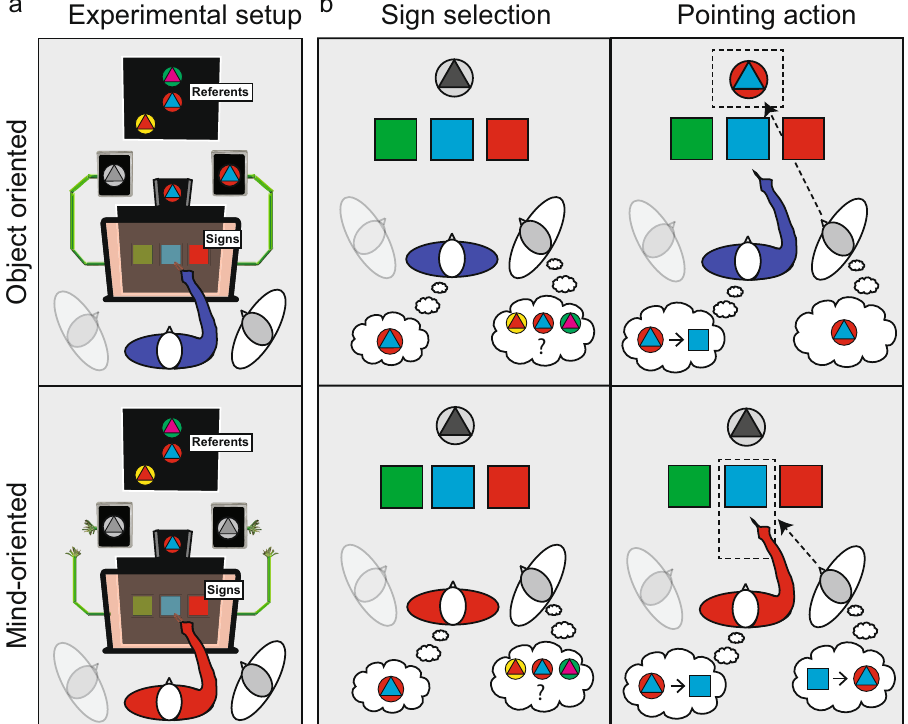
Figure 1. Experimental task. A schematic illustration of the experimental setup ( a ) and the trial interactions ( b ) in the object-oriented (top row) and mind-oriented (bottom row) action conditions. In this example the communicator plays the game with the right addressee, the left participant is the onlooker. Participants were asked to jointly open a vault. Only the addressee could enter the code (one of the referents), but only the communicator knew the correct code. To solve the game, the communicator needed to signal the correct referent to the addressee by pointing to one of the three signs, moving through a position-detection system. ( a ) The participants were informed that the vault’s computer system would analyse online the communicator’s pointing movement towards the signs and display the corresponding referent to the addressee (object-oriented trials). However, sometimes the display would not work (mind-oriented trials). On those trials, the addressee could infer the corresponding referent by means of the pointing movement of the communicator. ( b ) Left panels depict the sign selection phase (identical for object- and mind-oriented conditions) in which the communicator selects the sign that denotes the correct referent most clearly (the duration of this phase is the ‘reaction time communicator’). Right panels depict the pointing action towards the chosen sign. Subsequently, the addressee is either visually informed about the identity of the computer matched referent (object-oriented) after the movement had been completed, or infers the correct referent from the pointing movement itself (mind-